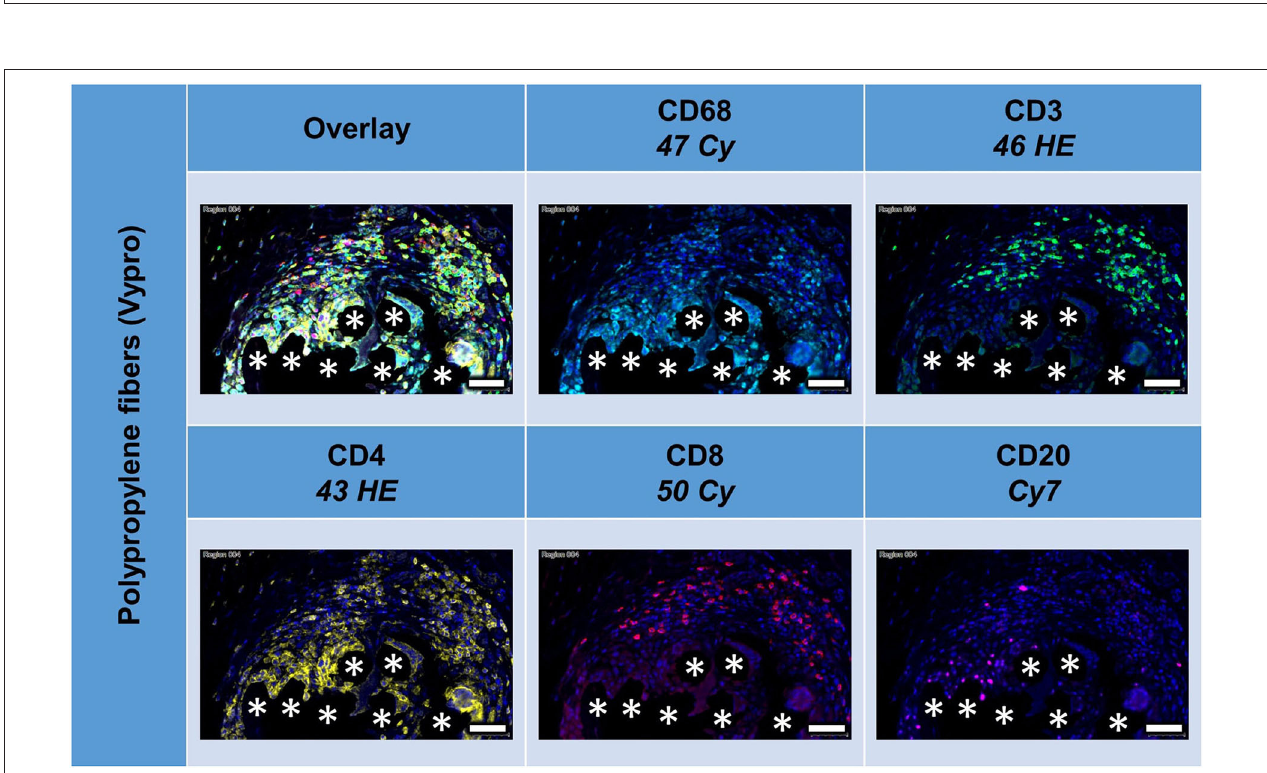
FIGURE 3 | Examples of linear scatter plots from macrophage panel. Scatter plots of mean cellular intensities of two markers in a 1 mm 2 ROI placed around fibers of a PP mesh plug. Lines in the scatter plots mark the cut-off value 100. Cytometric analysis was performed with StrataQuest 7. Asterisks mark fiber locations.